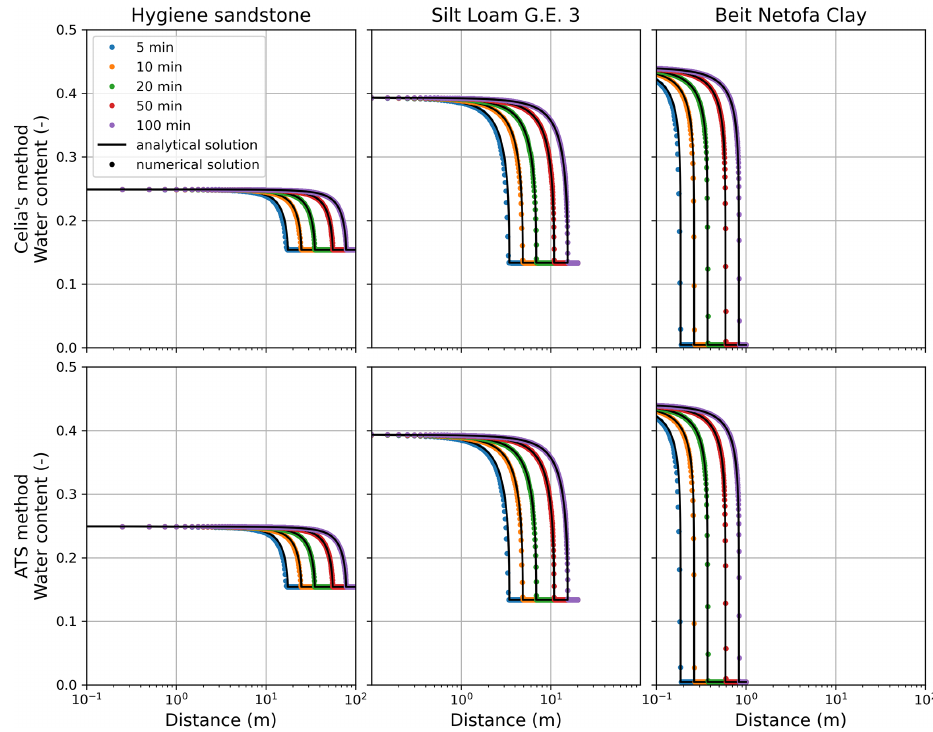
Figure 5. Comparison of our ATS solver flux output model for horizontal infiltration with the Mathias and Sander (2021) pseudospectral similarity solution (denoted analytical in the legend).